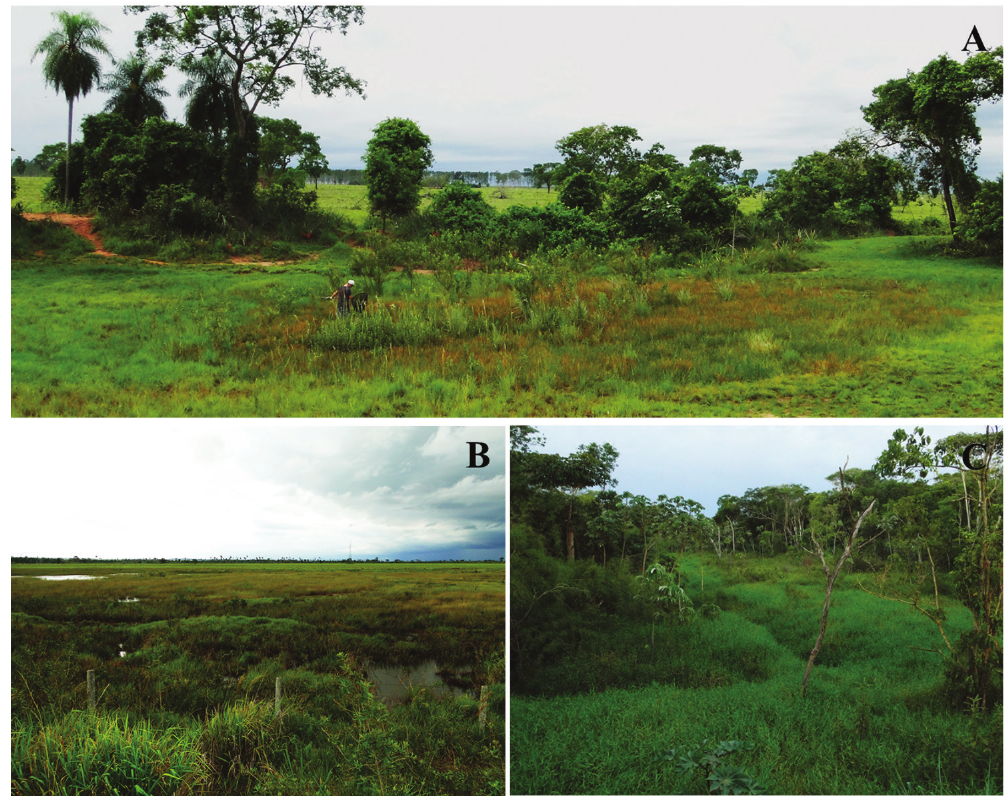
Figure 7. Sampling sites of Melanorivulus ivinhemensis sp. n. ( a ) Wetland associated with a small drainage, direct tributary of Rio Ivinhema, type locality, ( b ) wetland along BR 376 highway, ( c ) small drainage, direct tributary of Rio